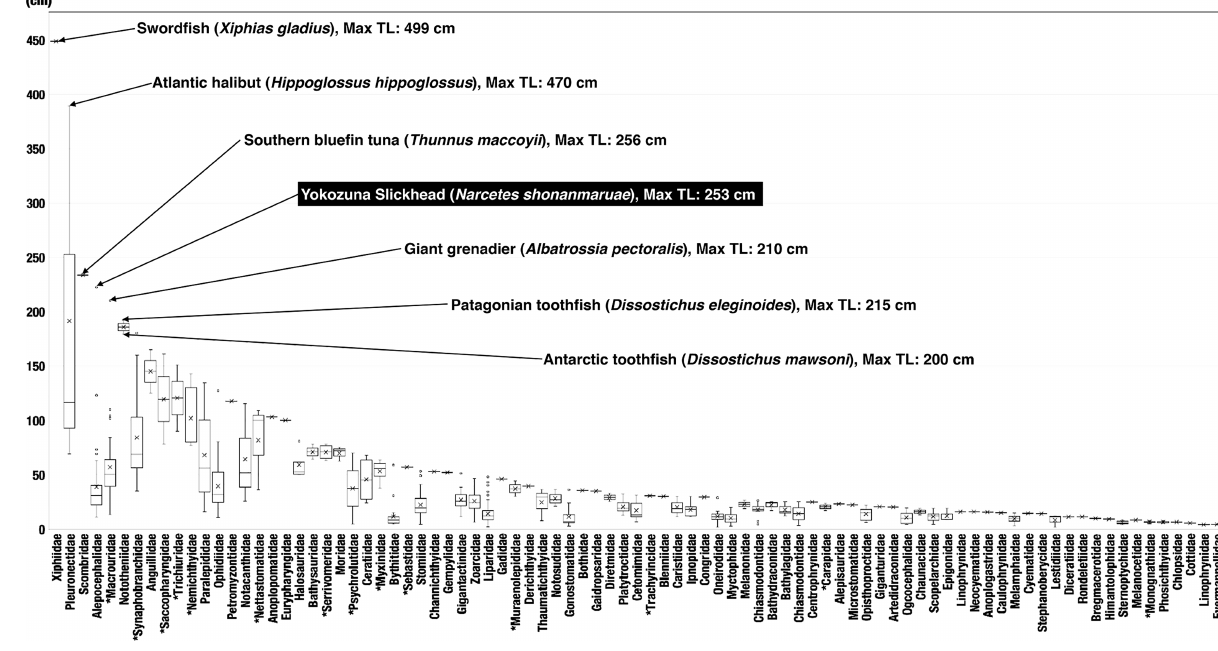
FIGURE 3 | Box plot of maximum standard length (SL) of teleost species that live deeper than 2,000 m from each family. Species with total length (TL) over 2 m are labeled. Size information is primarily based on FishBase (www.fishbase.org). The Yokozuna Slickhead is highlighted. *families displayed in